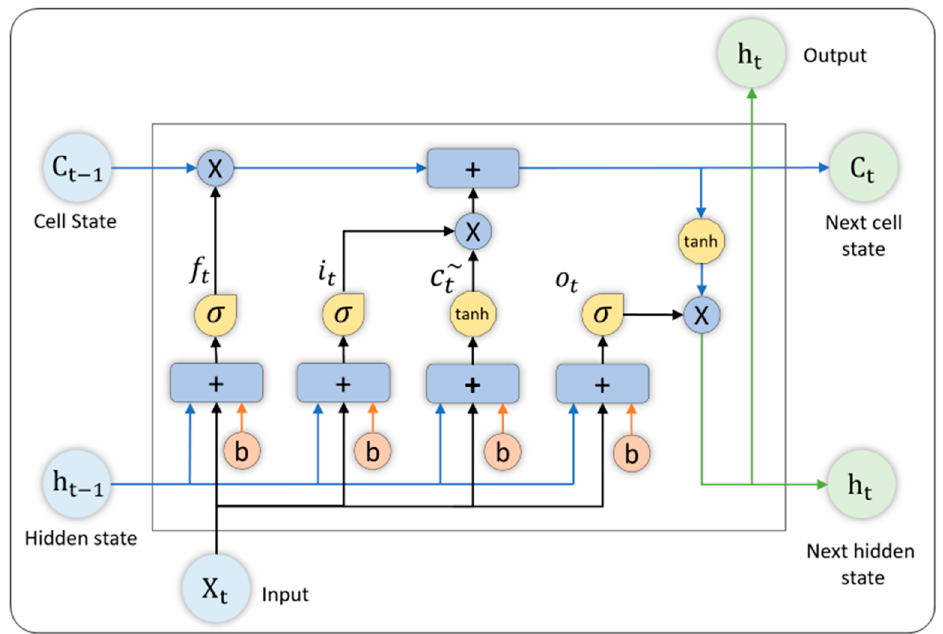
Figure 3. The structure of the LSTM model.